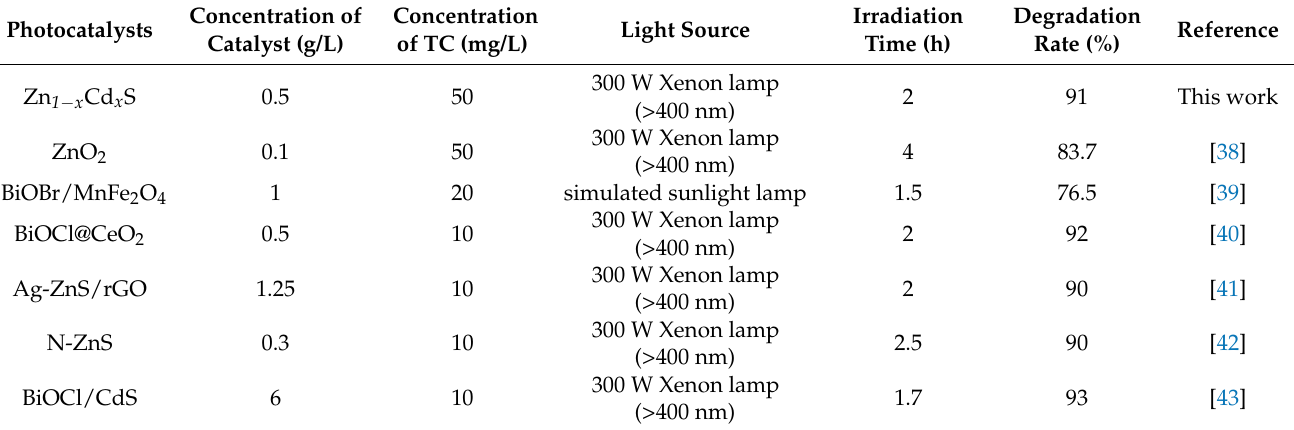
Table 1. Comparison of the performance of different photocatalysts for TC degradation.